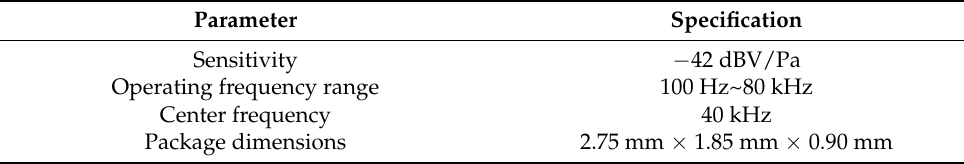
Figure 4. Hardware of the MEMS microphone array (with a size of 12 cm × 11 cm). Table 1. The main parameters of SPV08A0LR5H-1